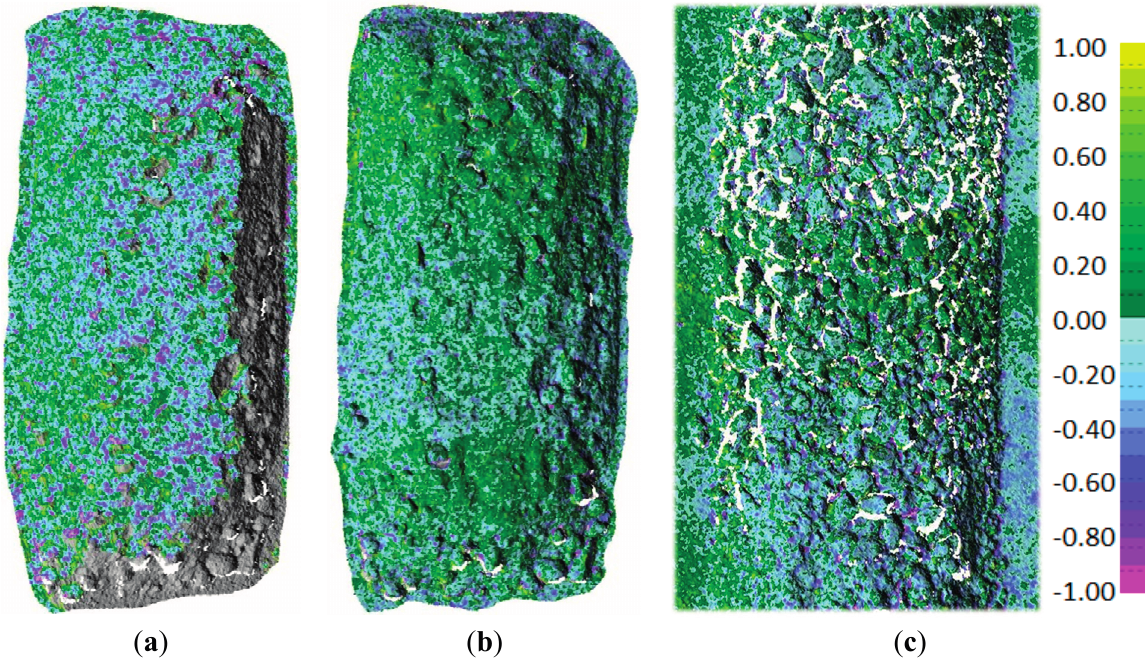
Figure 3. Map of distances (in mm) between the DSM generated with: ( a ) PhotoScan (PS) and Dense Matcher (DM) by using the same image pair; ( b ) PS and DM using the same sequence of three images; ( c ) PS using two different image pairs extracted from an image sequence of a laboratory